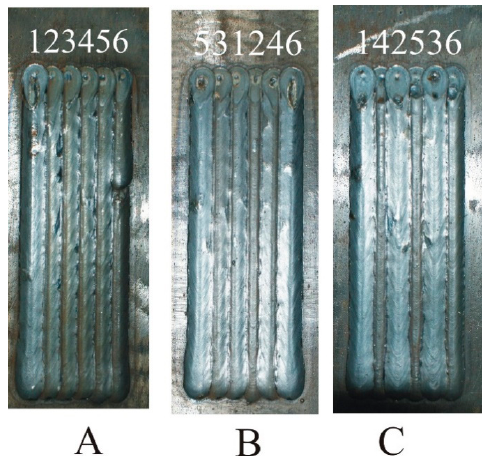
Figure 1. Photographs of plates with padded welds marked by a sequence of beads.